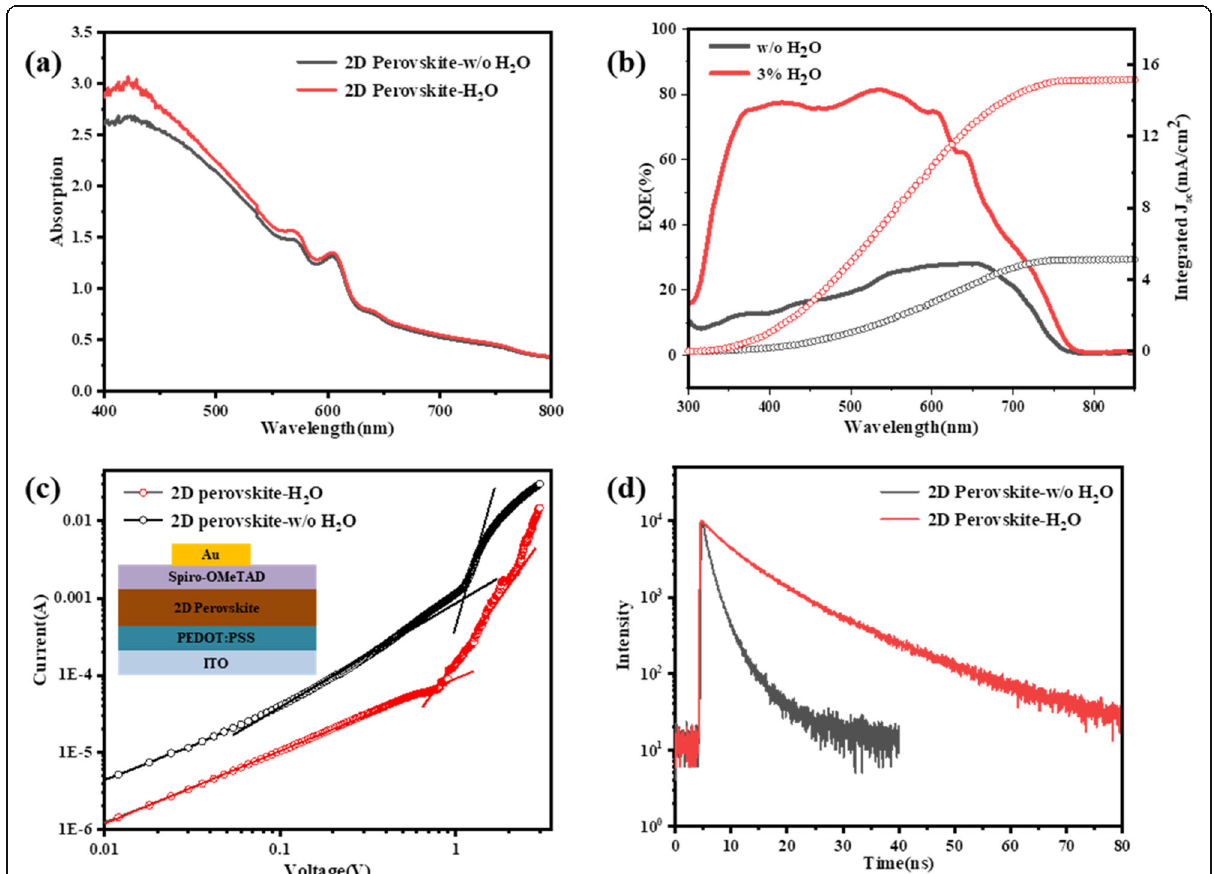
Fig. 4 a Absorption spectra of BA 2 MA 3 Pb 4 I 13 films without and with 3% H 2 O. b EQE spectra and integrated current curve of corresponding devices. c Dark current-voltage curves of the HODs based on corresponding 2D perovskite films (inset: configuration of HODs). d TRPL spectra of corresponding 2D perovskite